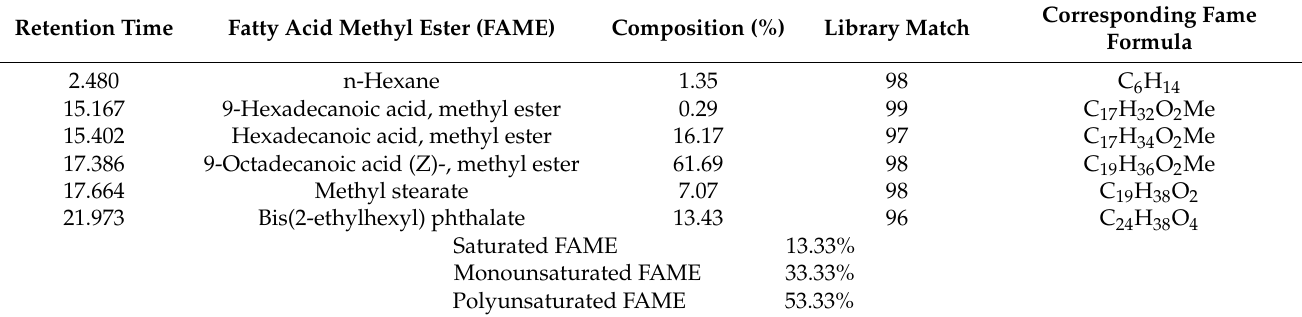
Table 3. Compounds detected from GC-MS of biodiesel.